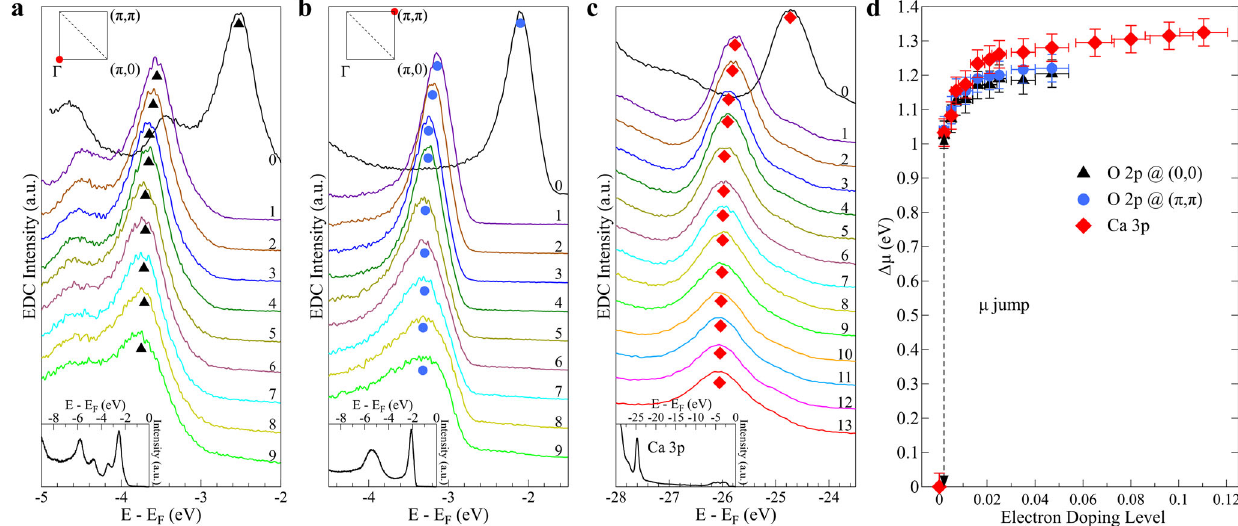
Fig. 4 Measured chemical potential shift with electron doping in Ca 3 Cu 2 O 4 Cl 2 . a – c Doping evolution of O 2 p orbitals at Γ ( a ) and ( π , π ) ( b ), and Ca 3 p core level ( c ). Symbols in ( a – c ) indicate the respective spectral peaks. The photoemission spectra of the undoped parent compound in a larger energy scale are shown in the respective insets. d Chemical potential shift with electron doping determined from the three types of measurements in ( a ), ( b ), and ( c ). The chemical potential shift for the undoped parent compound is set at zero as a reference. The chemical potential shifts obtained from the three cases give a similar result with a jump of ~1 eV in the initial Rb-deposition stage. Error bars re fl ect the uncertainty in determining the EDC peak